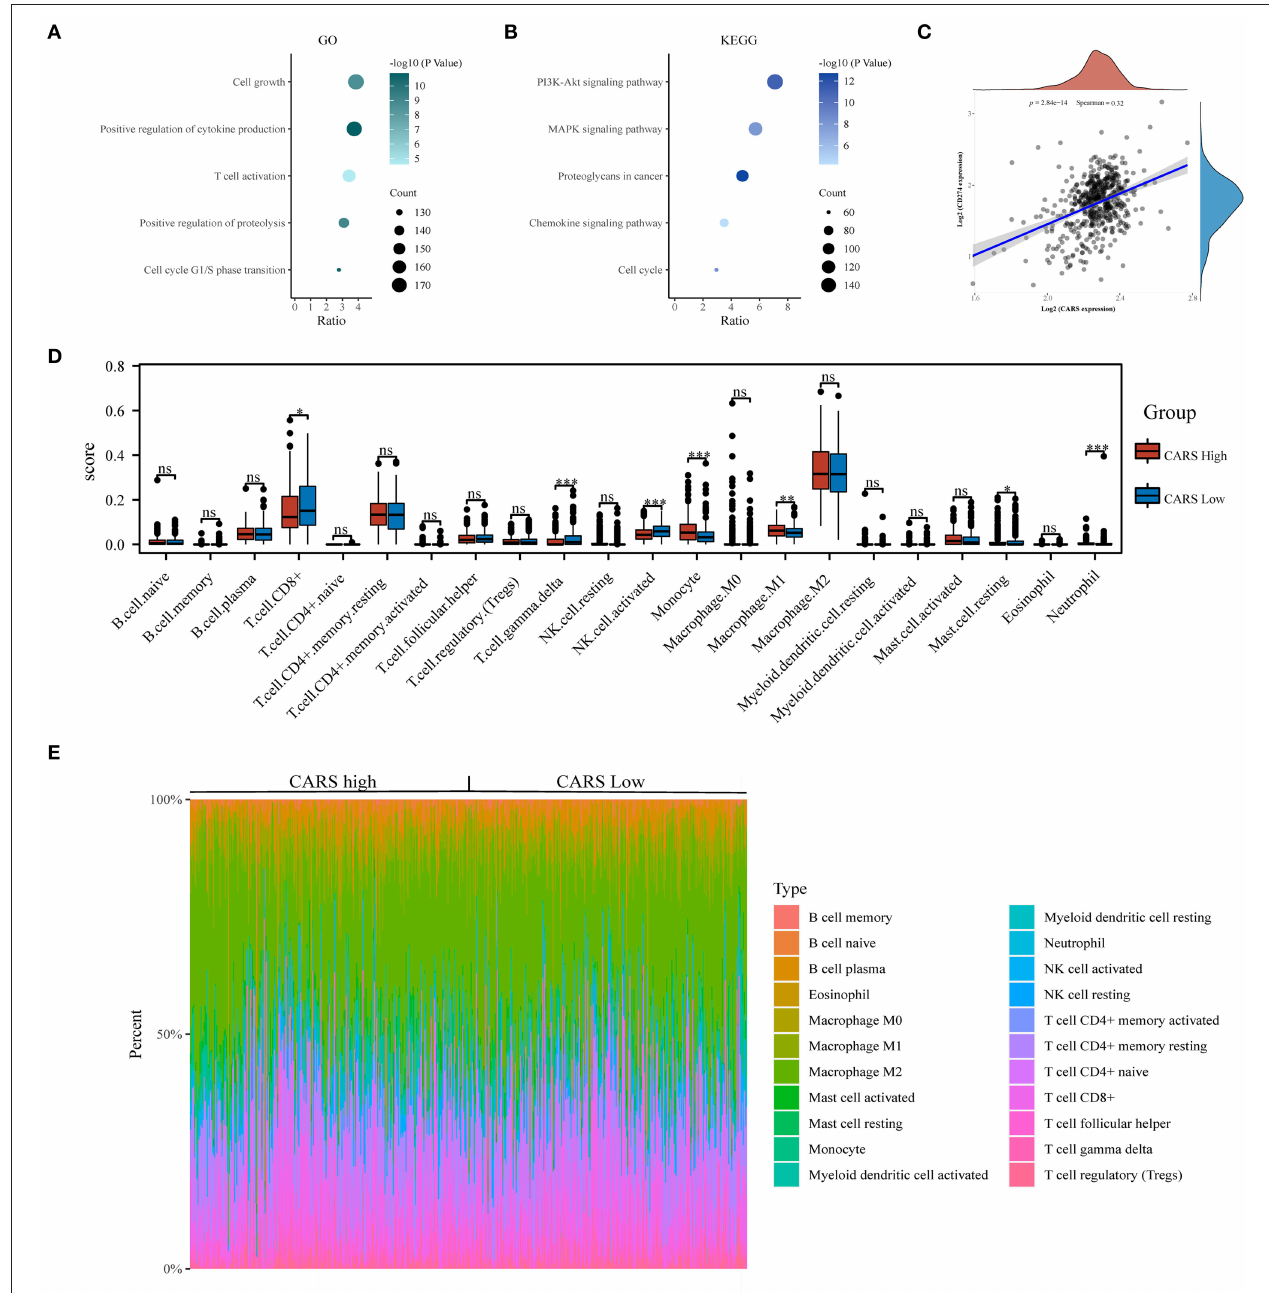
FIGURE 7 | Correlation analysis of CARS expression with PD-L1 and infiltrating immune cells in clear cell renal cell carcinoma (ccRCC). (A,B) The enriched Gene Ontology (A) and Kyoto Encyclopedia of Genes and Genomes signaling pathways (B) analysis of highly expressed CARS in ccRCC. (C) Spearman correlation analysis of CARS expression and PD-L1 expression in ccRCC. (D) The infiltrating levels of immune cells in high and low CARS expression groups in ccRCC patients. (E) The heat map visualized the percentage abundance of tumor-infiltrating immune cells in each sample. * p < 0.05, ** p < 0.01, and *** p < 0.001.